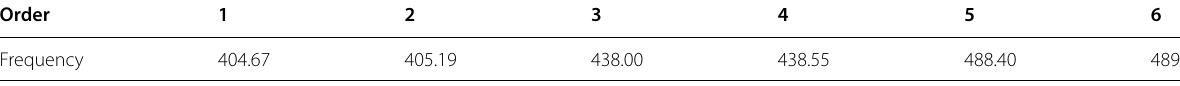
Table 6 The normalized frequencies of cylindrical shell with a random mistuned restraint stiffness sample with σ k Order